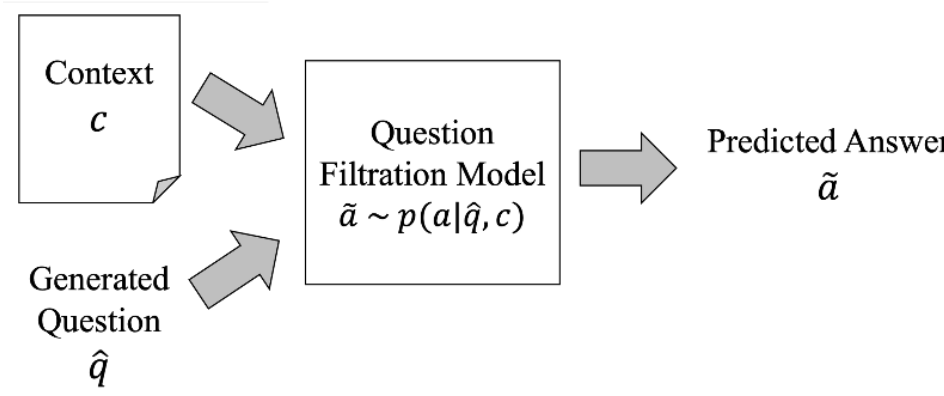
Figure 6. The inputs and the output of the Question Filtration model.